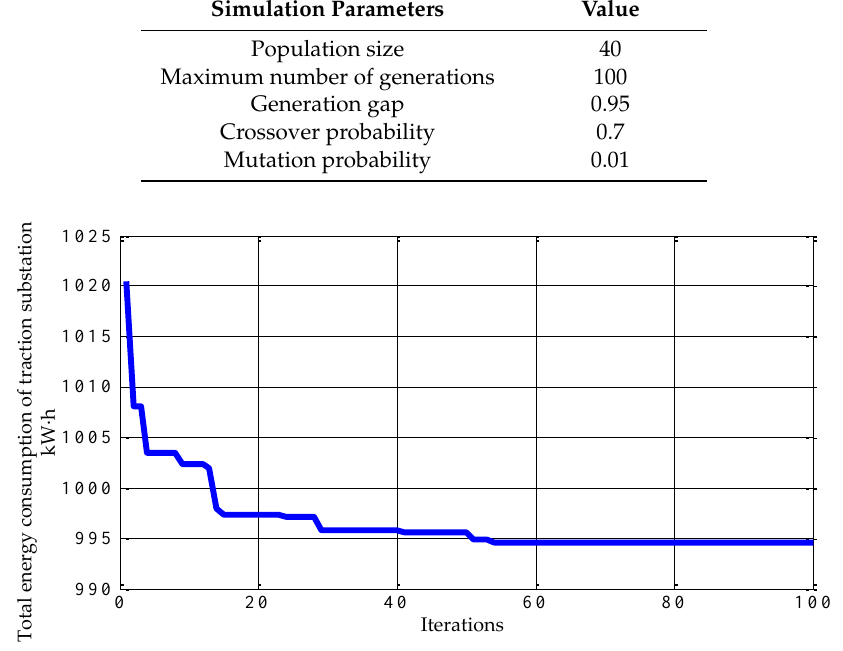
Figure 14. Evolution of searching for the optimal solution.